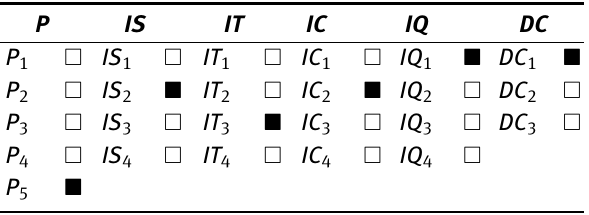
Table 6: Risk “Over-engineering” - Risks Identified in Piping Design. P IS IT